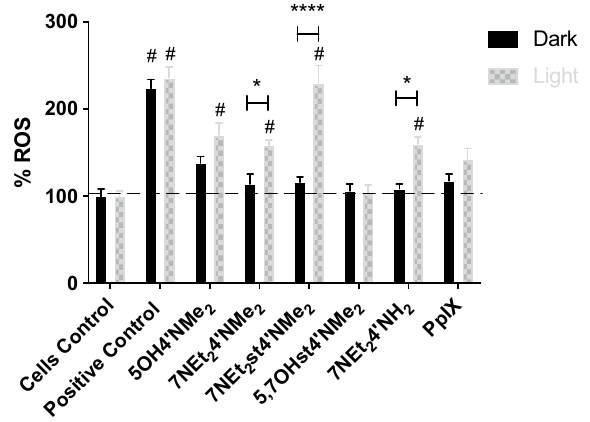
Figure 7. Production of reactive oxygen species by the different compounds at 25 μM upon white light irradiation (6.6 J cm −2 ) or in dark maintenance. As cells control, cells were not treated with any compound but the addition of DCF-DA was performed. As positive control the cells were treated with H 2 O 2 (100 μM) 30 min prior to the addition of DCF-DA to induce a high production of ROS. Each value represents the mean ± SEM (n = 8–16). *Means treatment in dark significantly different to the treatment with the white light (*p value < 0.05; ****p value < 0.0001). # Means significantly different from the respective control cells (cells without any concentration of compound): dark or white light treatment. To perform both statistical analysis, two-way ANOVA with Sidak’s multiple comparisons test was performed.